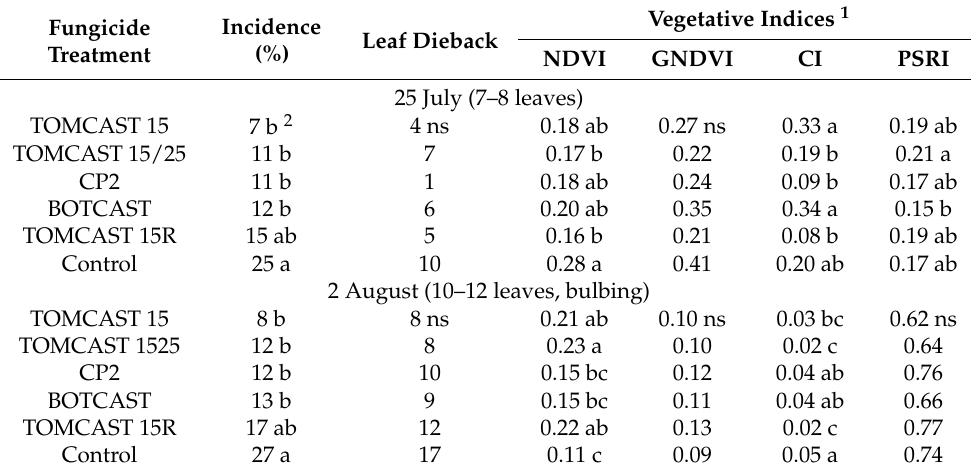
Table 4. Stemphylium leaf blight incidence, leaf dieback, and vegetative indices were measured on onions in a fungicide application timing trial at the MCRS, Holland Marsh in